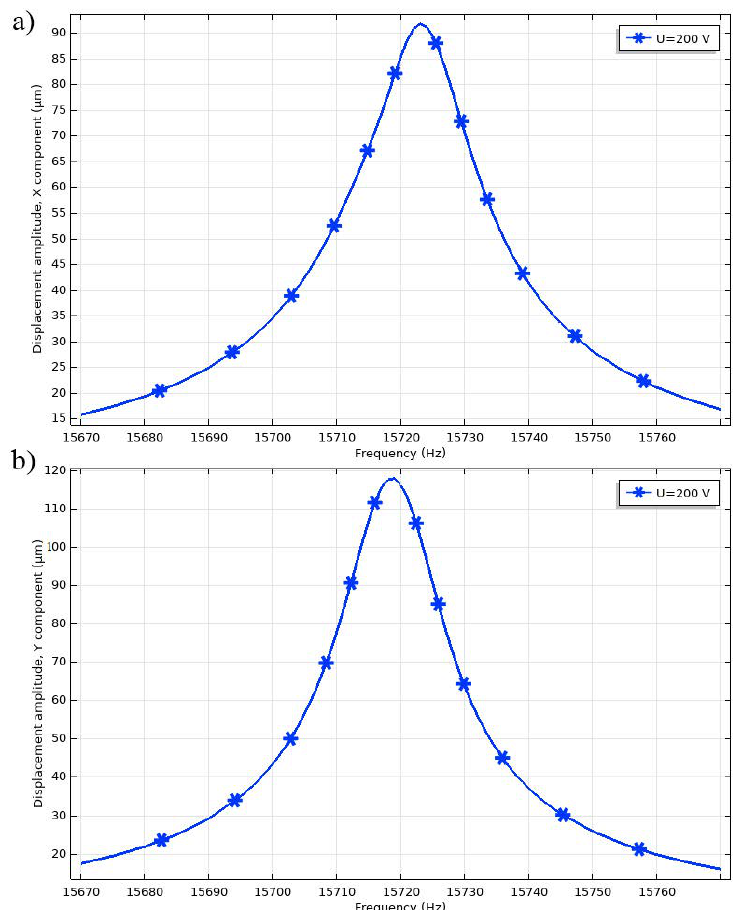
Figure 8. Displacement amplitudes of the contact point at different excitation voltage; ( a )—displacement amplitude in the X direction; ( b )—displacement amplitude in the Y direction.